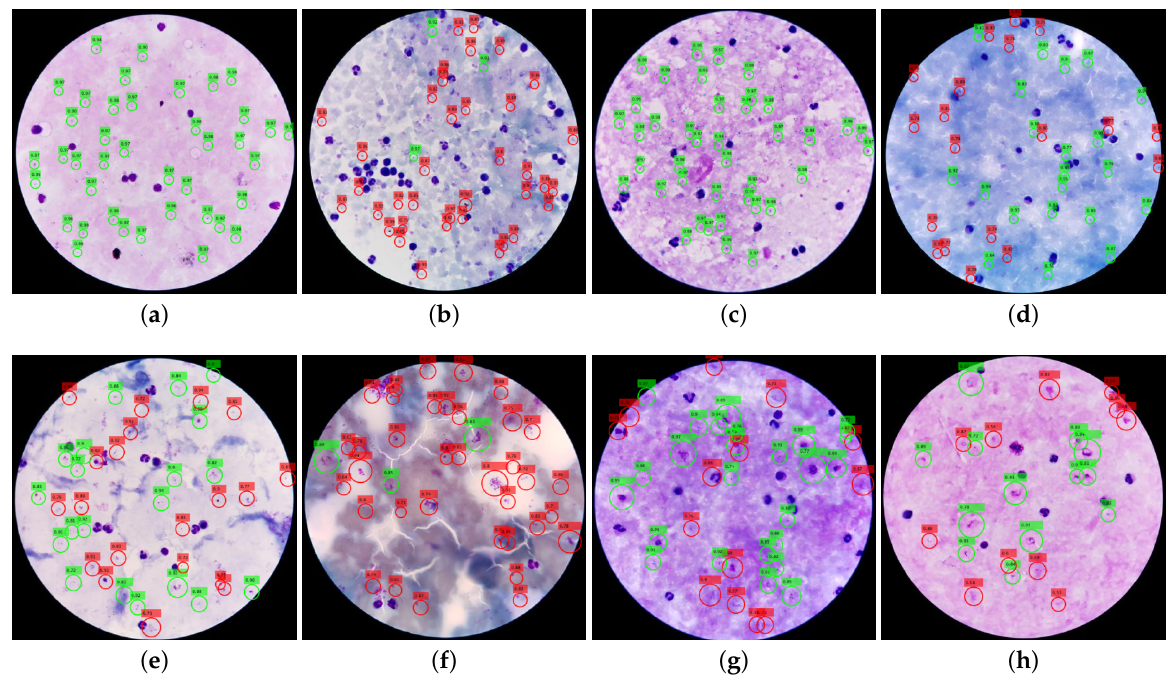
Figure 6. Mask R-CNN parasite detection in eight different patients—four images from different patients (top row) infected with P. falciparum and another four from different patients (bottom row) infected with P. vivax . The figure shows how the images vary in color and infection rate. Green circles are true positives, while red circles are false positives. We draw the circles larger than the actual parasites for better visualization. Rec and Pre mean recall and precision. ( a ) P. falciparum parasite detection with Pre = 100% and Rec = 50%. ( b ) P. falciparum parasite detection with Pre = 10% and Rec = 100%. ( c ) P. falciparum parasite detection with Pre = 100% and Rec = 10%. ( d ) P. falciparum parasite detection with Pre = 50% and Rec = 50%. ( e ) P. vivax parasite detection with Pre = 50% and Rec = 80%. ( f ) P. vivax parasite detection with Pre = 10% and Rec = 80%. ( g ) P. vivax parasite detection with Pre = 60% and Rec = 90%. ( h ) P. vivax parasite detection with Pre = 50% and Rec =